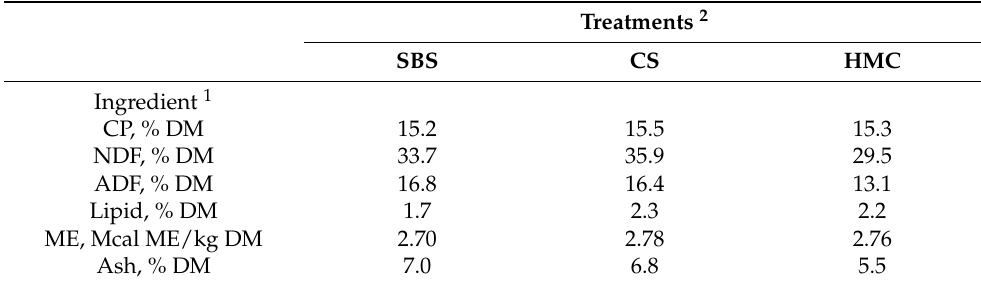
Table 1. Ingredients and chemical composition of